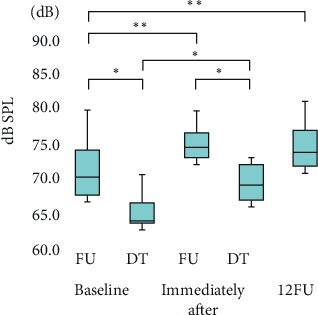
Reading a passage.